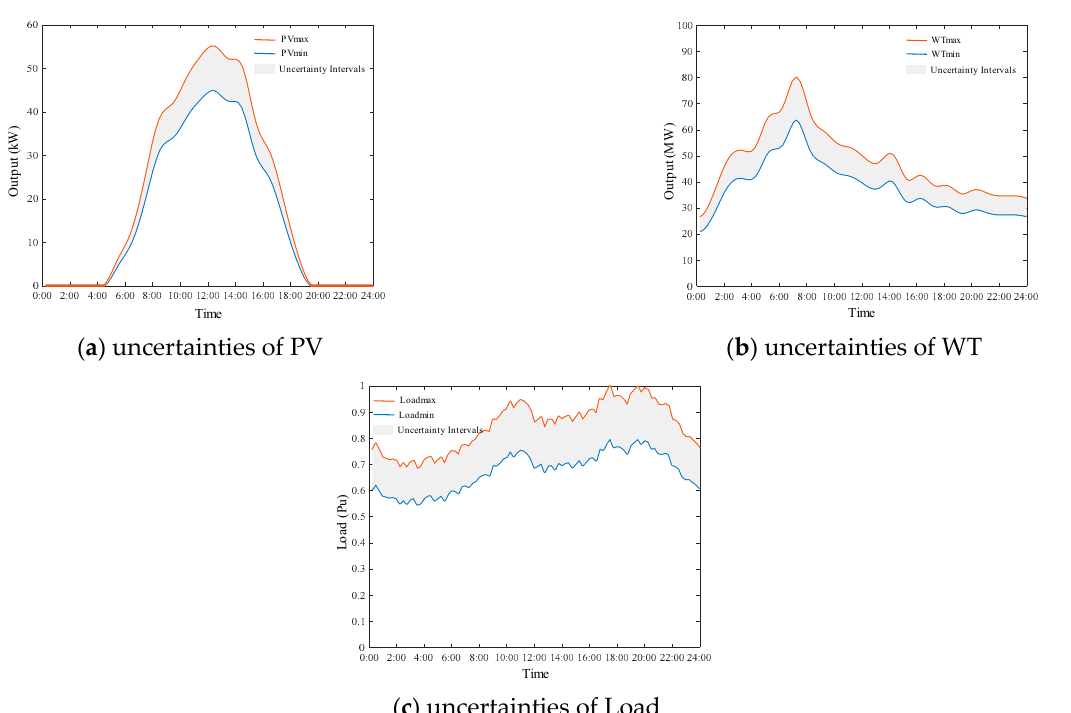
Figure A1. Interval forecast of PV output, WT output and load (per unit). Table A1. Parameters of energy storage system (MG).